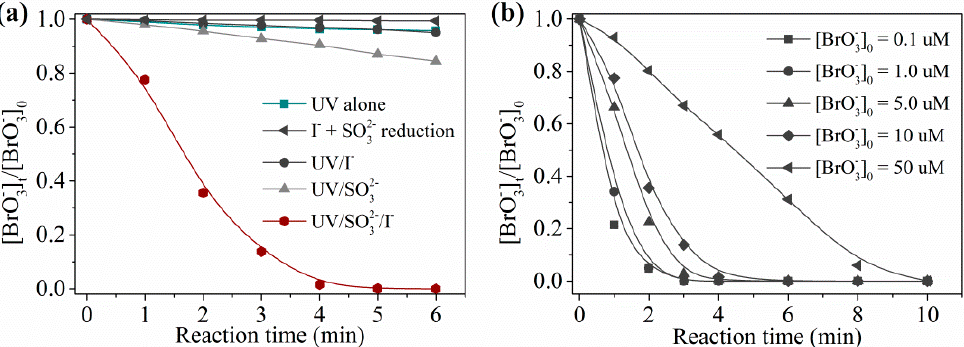
Figure 1. Efficiency of BrO − degradation by ultraviolet (UV)/sulfite/I − in prepared water: ( a ) different processes; ( b ) different concentrations of BrO − . Conditions: [I − ] 0 = 100 µ M, [sulfite] 0 = 1.0 mM,